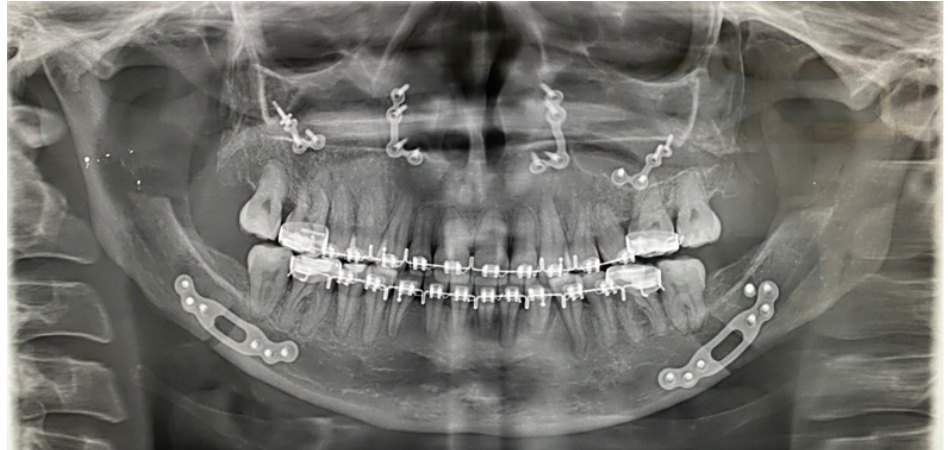
Figure 5. Final result after combined Lefort I and BSSO osteotomy to restore facial balance, mandibular symmetry, adequate maxillary position, and correction of the deviated bite plane. On the left side, a bigger bone gap is present which refers to the rotation of the mandible towards the right side to restore a symmetric midline.